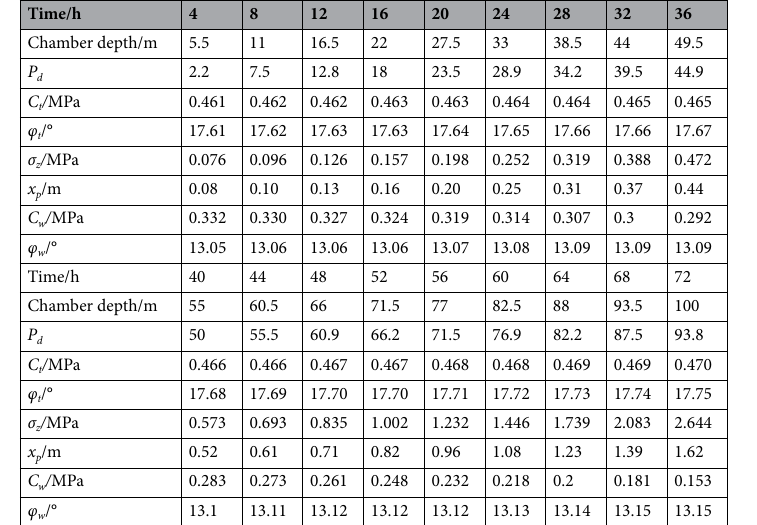
Table 4. Slice width distribution pattern and evolution weak layer parameters of a 5.8-m-wide coal pillar.